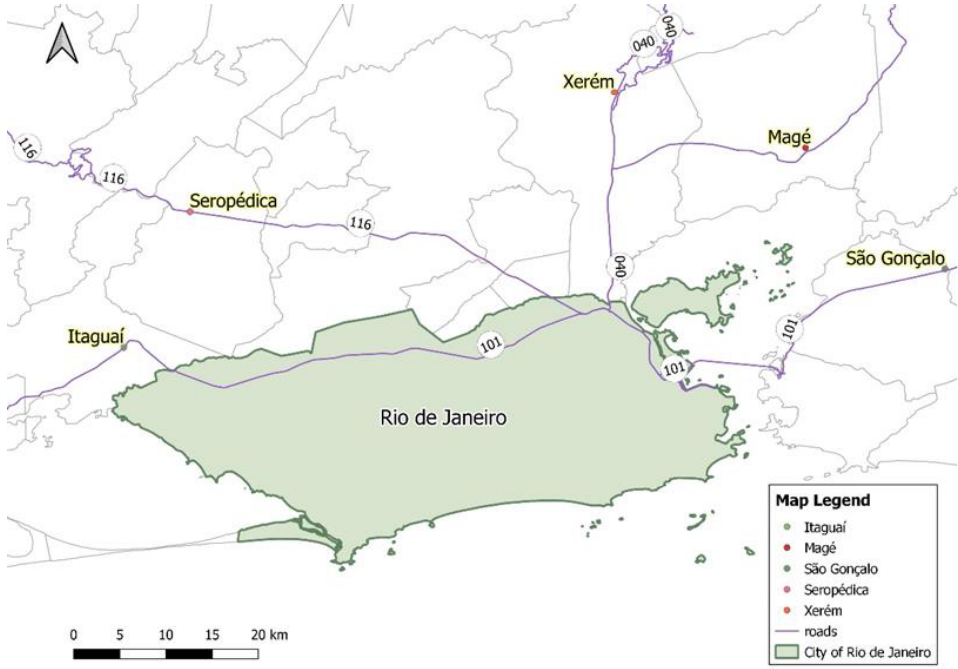
Figure 1. Toll plazas and radar location for data extraction. Itaguaí has radar with volumetric count.